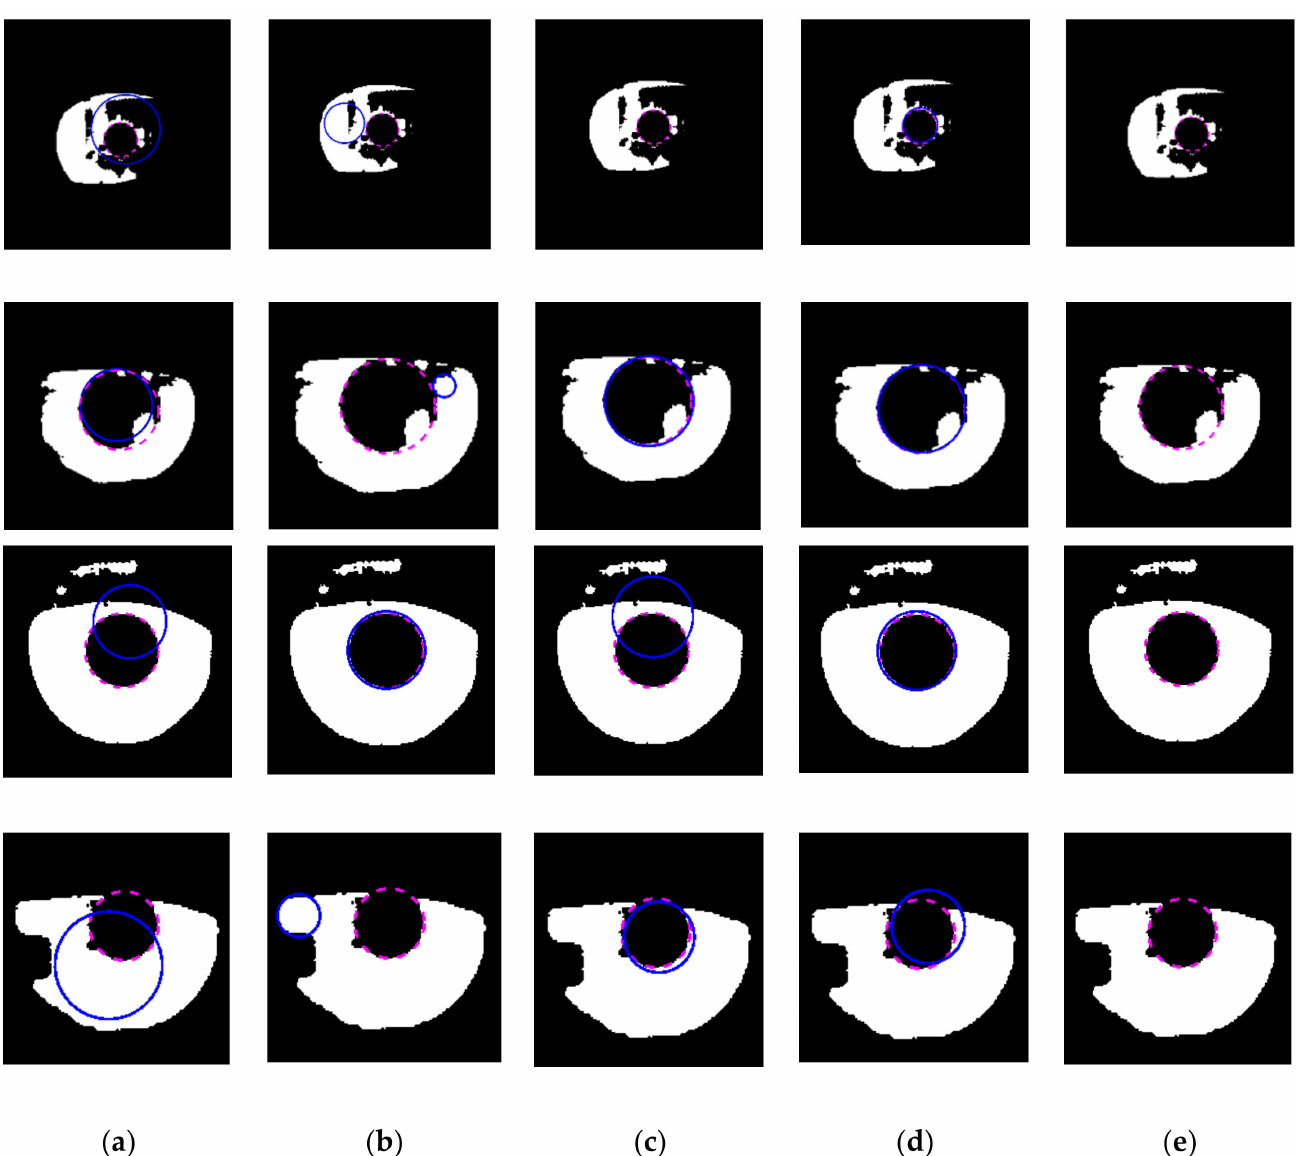
Figure 16. Failure cases on challenging images compare with other works to recover the inner boundary. ( a ) Proposed method; ( b ) Li et al. [4]; ( c ) Li and Huang [8]; ( d ) Ronneberger et al. [37]; ( e ) Duda and Hart [46]. The dashed line denotes the ground-truth and the blue line denotes the prediction of the inner